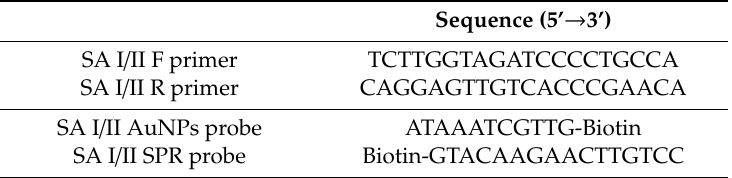
Table 1. Polymerase chain reaction (PCR) primers and surface plasmon resonance (SPR)